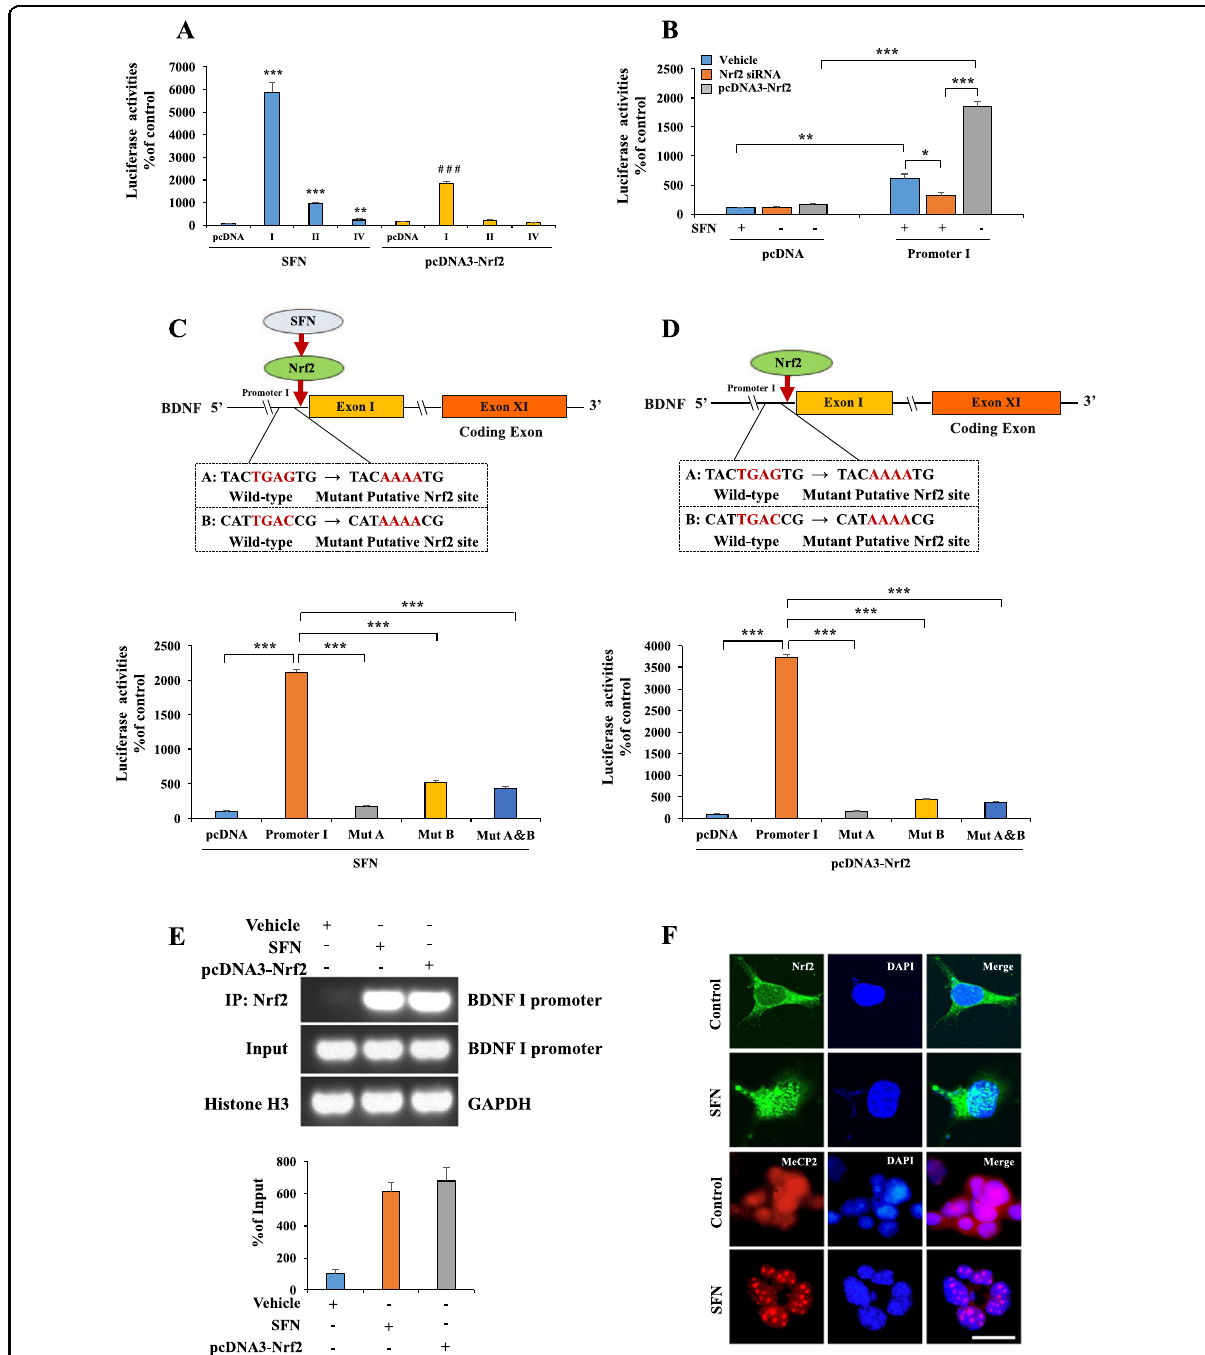
Fig. 2 Nrf2 acts as transcription factor for BDNF. A – E Nrf2 acted as a transcription factor for BDNF promoters. A , B BDNF exons I, II, and IV luciferase promoters and SFN or Nrf2 or siRNA-Nrf2 plasmids were treated into HEK293 cells (mean ± SEM, n = 4 per group, one-way ANOVA, * p < 0.05, ** p < 0.01, *** p < 0.001, and # # # p < 0.001). C , D Results obtained using the luciferase plasmids containing mutation (Mut) at the Nrf2 binding motif of BDNF exon I promoter was compared with the wild type of promoters, respectively (mean ± SEM, n = 4 per group, one-way ANOVA, * p < 0.05, ** p < 0.01, and *** p < 0.001). E ChIP-PCR assays demonstrated Nrf2 speci fi cally bound to genomic DNA of BDNF exon I promoter binding motifs. The Nrf2 protein – DNA crosslinking samples were obtained from the HEK293 cells treated with SFN or Nrf2 plasmid or not (control) via co- immunoprecipitating with anti-Nrf2 antibodies. PCR was carried out by using primer pairs at BDNF exon I promoter. PCR assay also included each input sample. The positive control was demonstrated with anti-Histone H3 antibody coupling with GAPDH primers. F The immuno fl uorescence for Nrf2 and MeCP2. The SFN treated for Neuro-2a cell 24 h. The immuno fl uorescence was performed for Nrf2 and MeCP2. Scale bar 50 μ